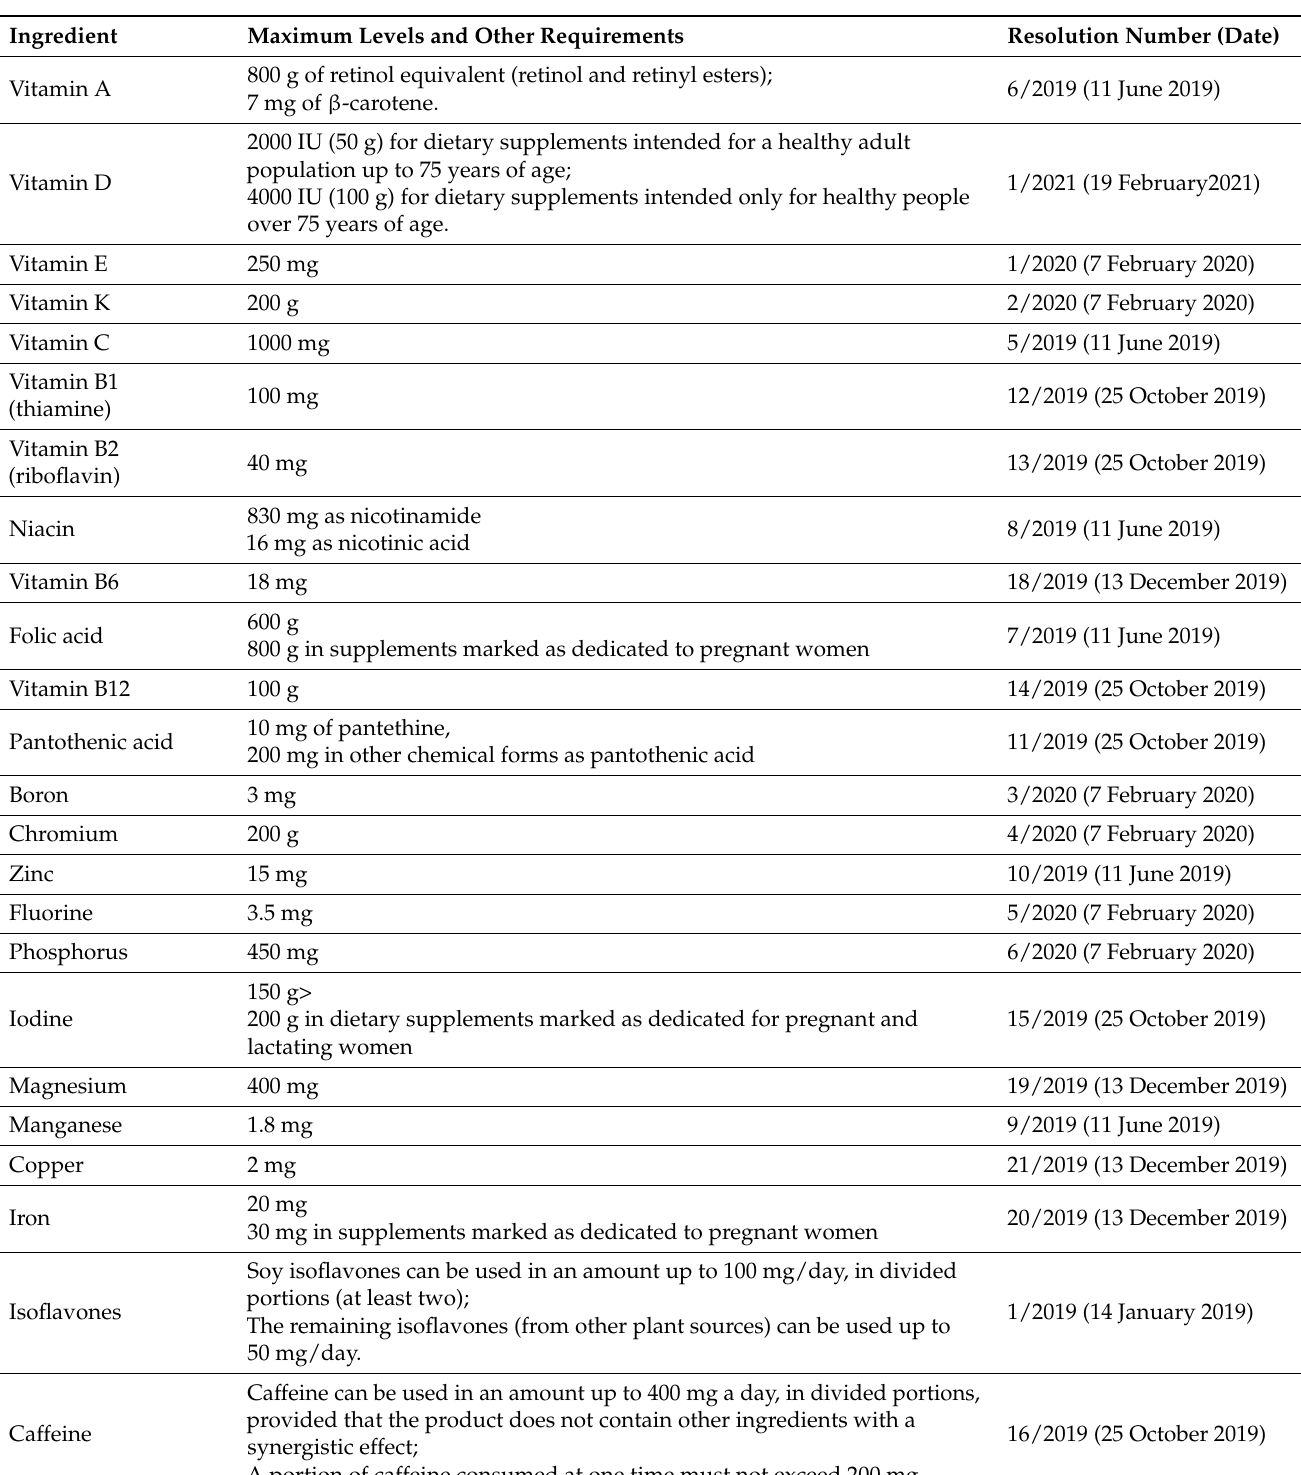
Table A1. Quality requirements and maximum levels of vitamins, minerals, plant ingredients and other ingredients with a physiological effect in dietary